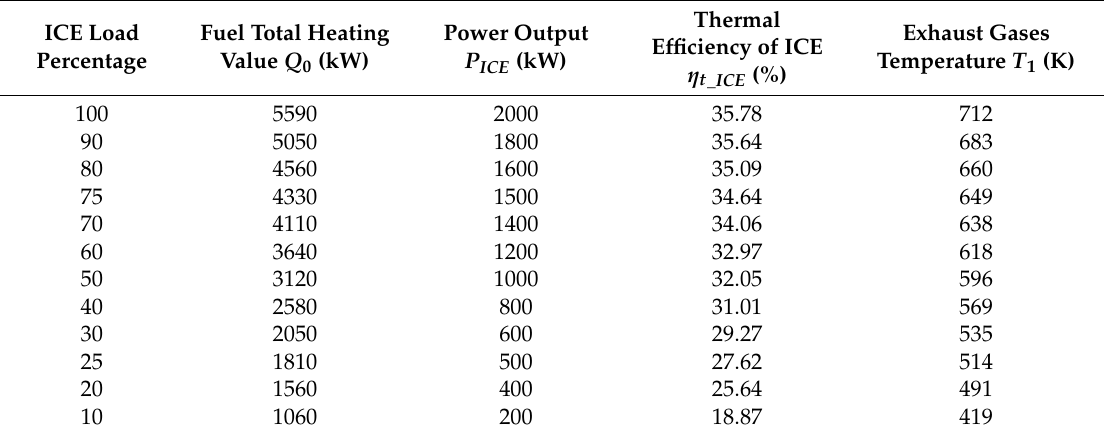
Table 5. Waste exhaust parameters at different ICE loads [22] ( p 1 = 101 kPa).